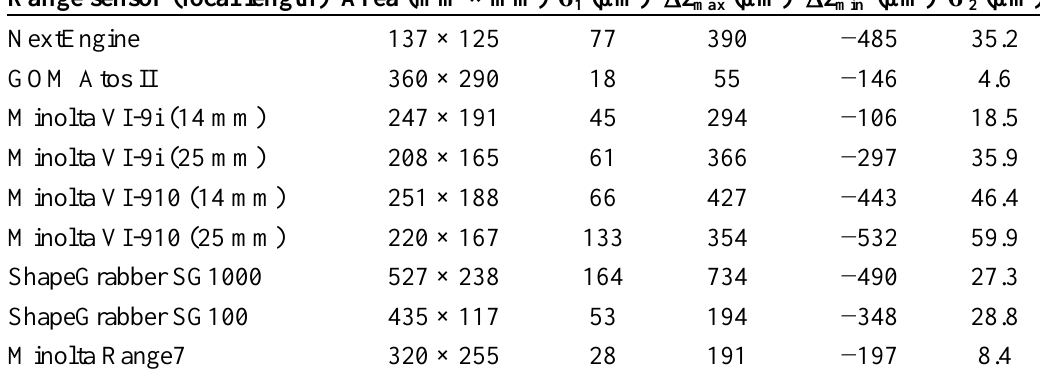
Table 3. Plane fitting parameters obtained from each analyzed range sensors; σ standard deviation evaluated on the whole range map while σ central